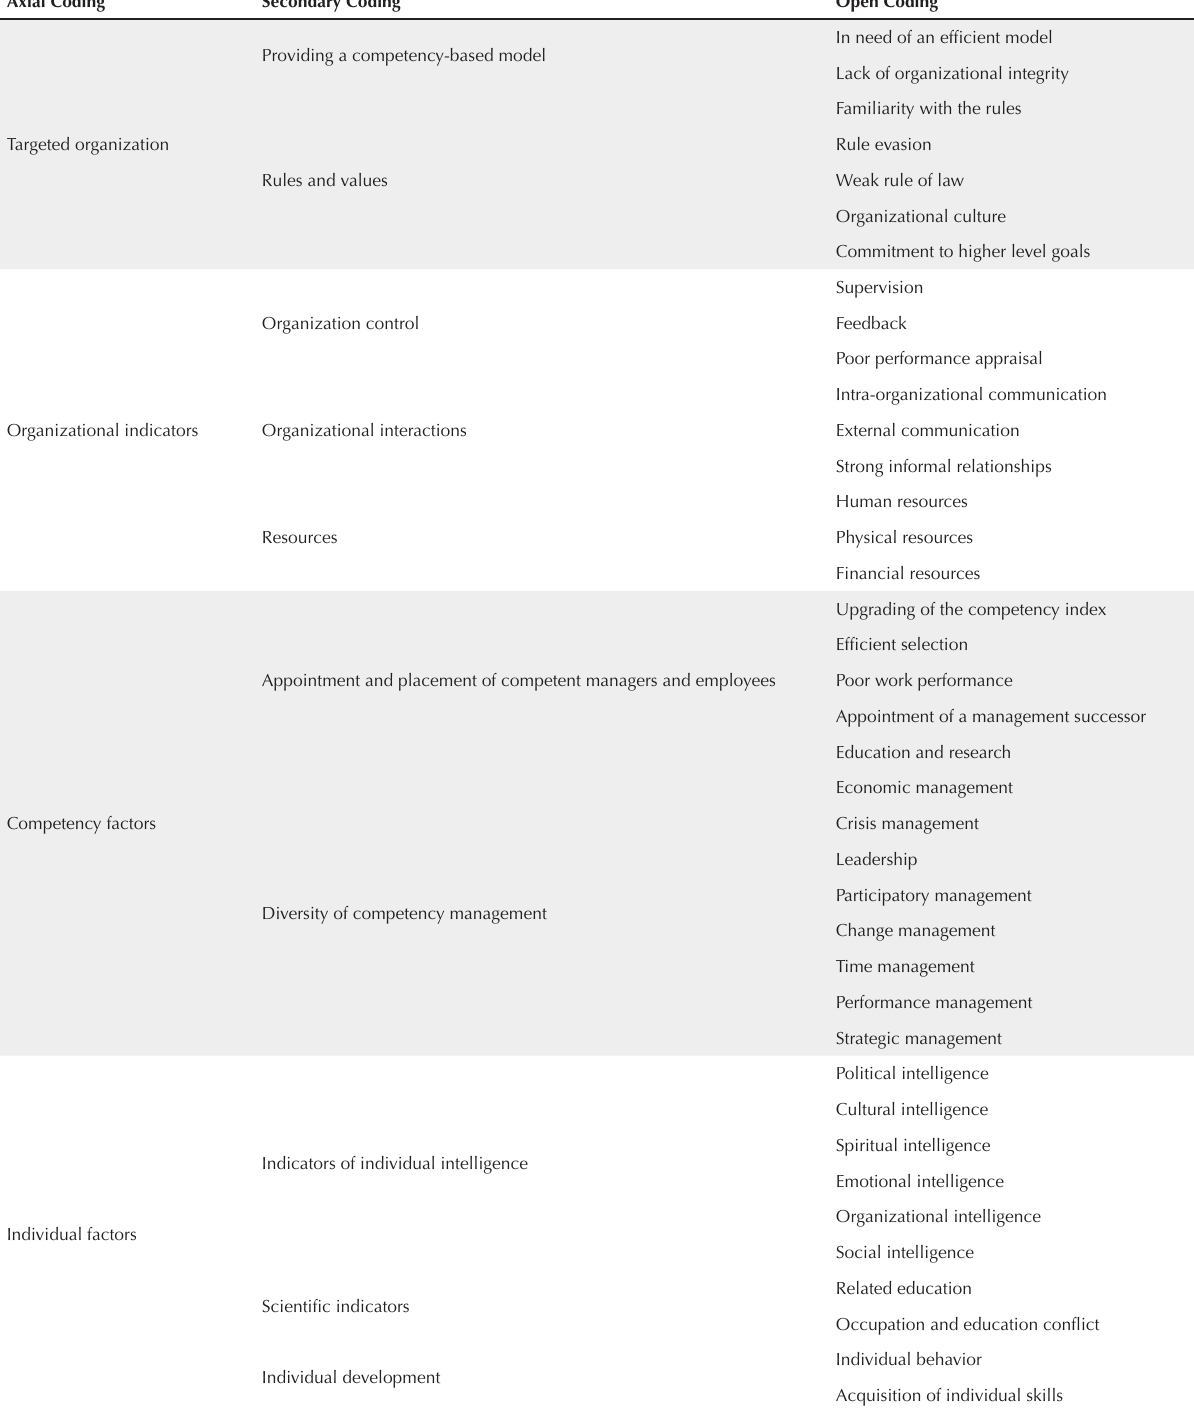
Table 1. Coding of qualitative data (causal conditions) Axial